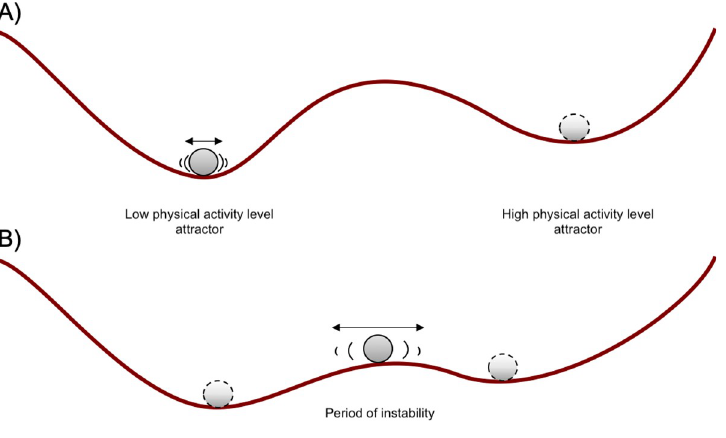
Fig 3. Attractor